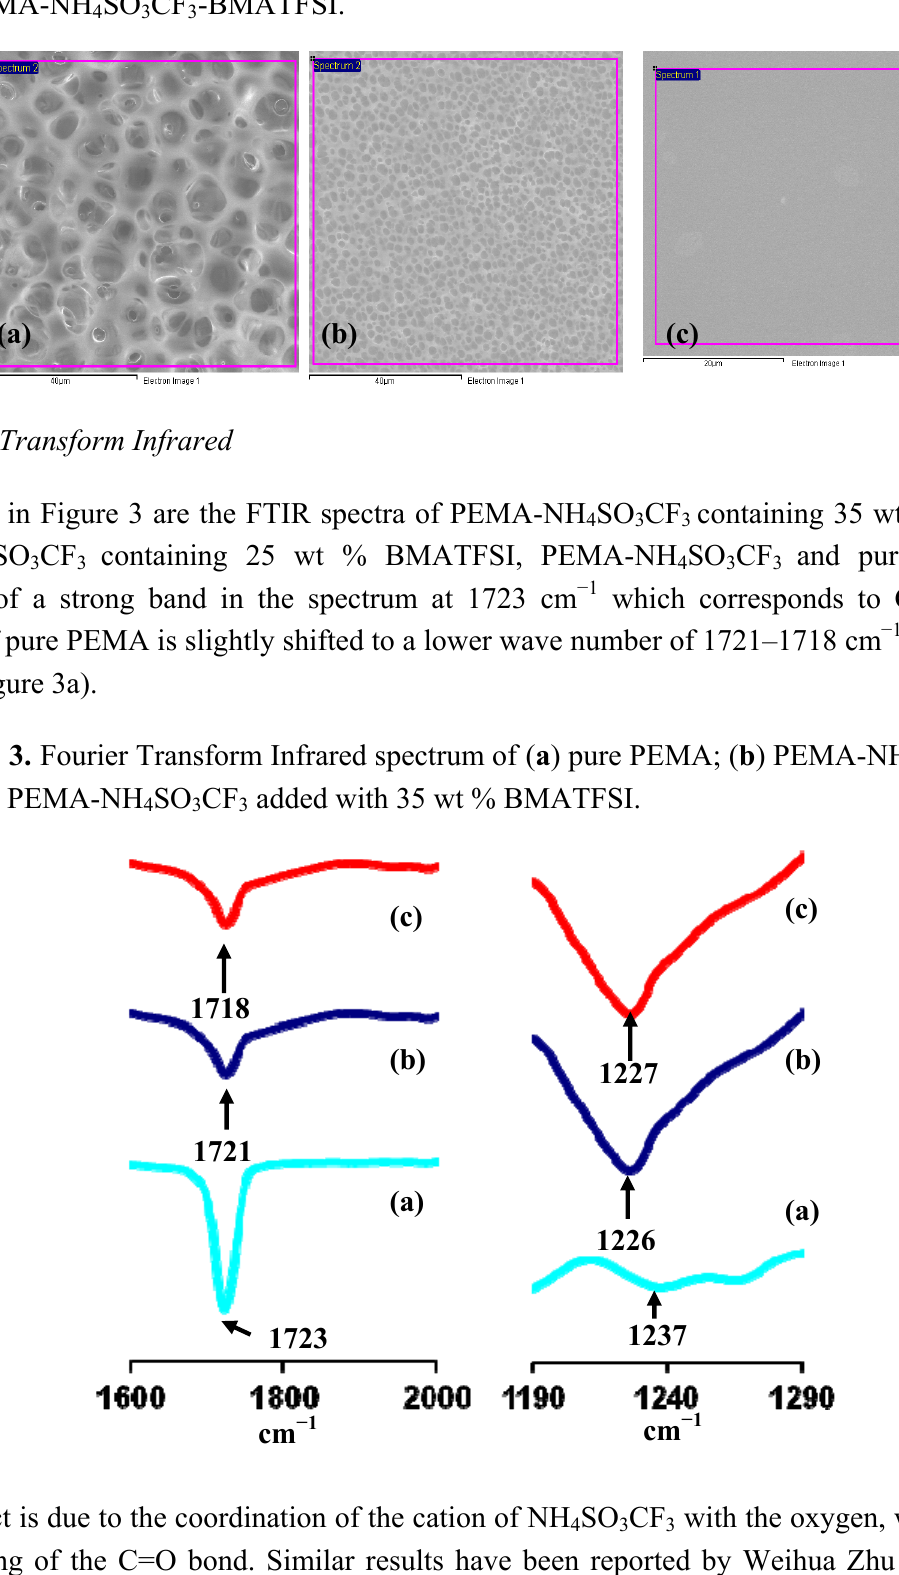
SO CF and 4 3 3